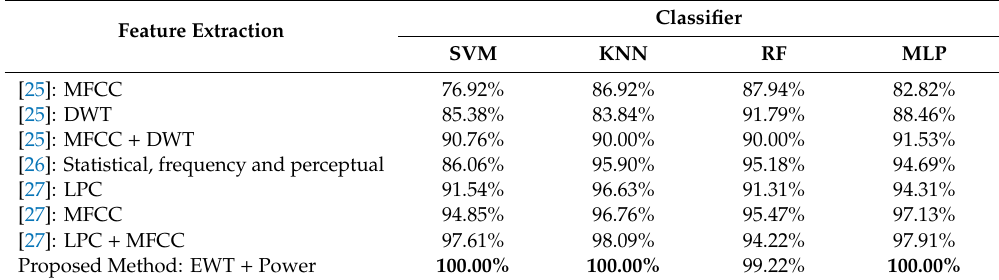
Table 13. Results of specificity between the methods in [25–27] and the proposed.